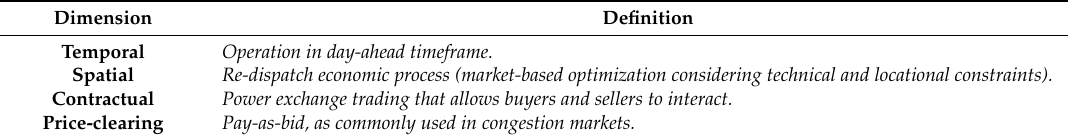
Table 2. Flex-DLM